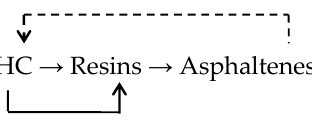
Table 1. Component composition and physicochemical properties of the initial heavy residual oil (HRO) and its oxidation products. Oxidation Time, min HC,